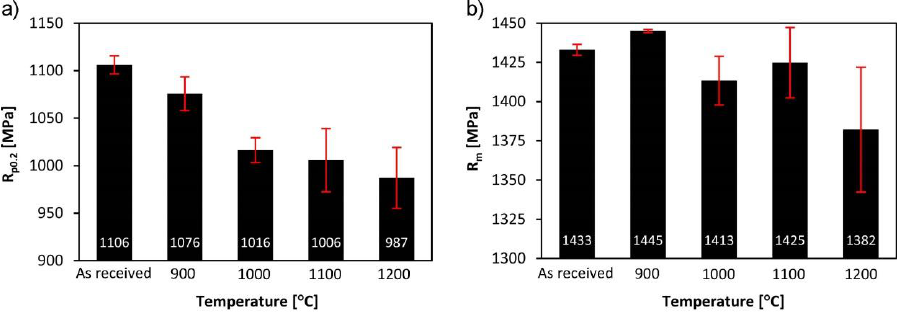
Figure 6. Tensile strength ( a ) and yield strength ( b ) of tested steel in the as-received state and after different austenitizing temperatures.